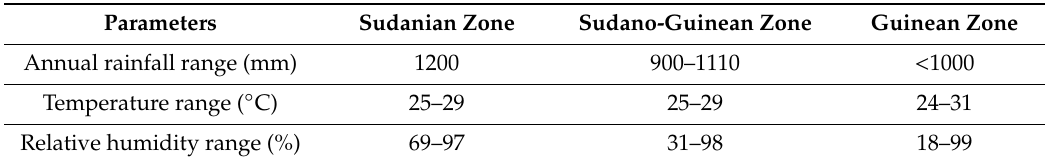
Table 1. Characteristics of Benin’s climatic zones.